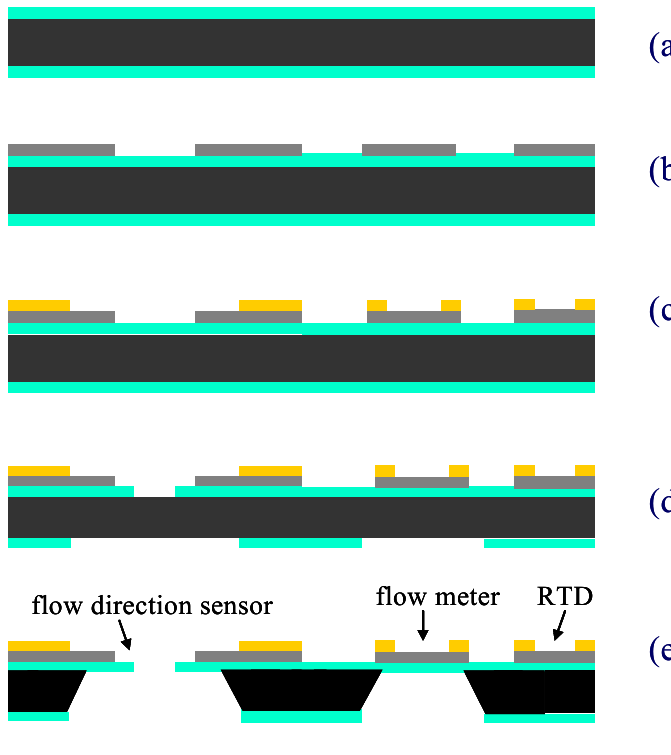
Figure 4. Schematic overview of fabrication process used to accomplish flow direction sensor with integrated flow meter and